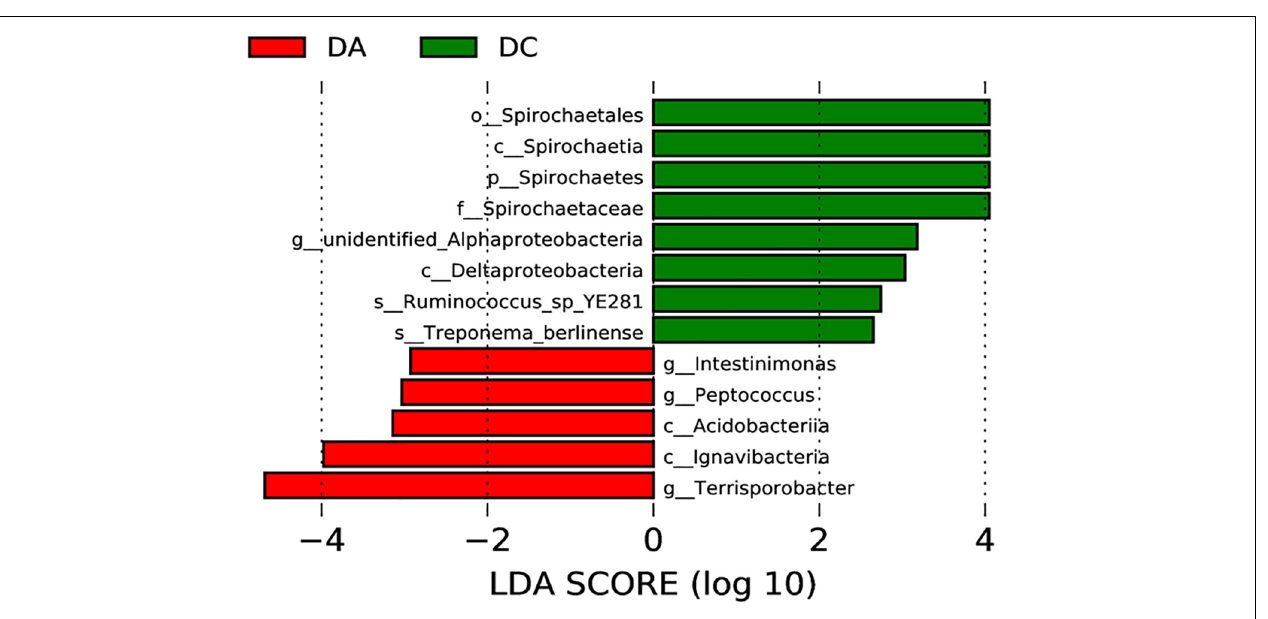
FIGURE 4 | Analysis of LEfSe multilevel species difference